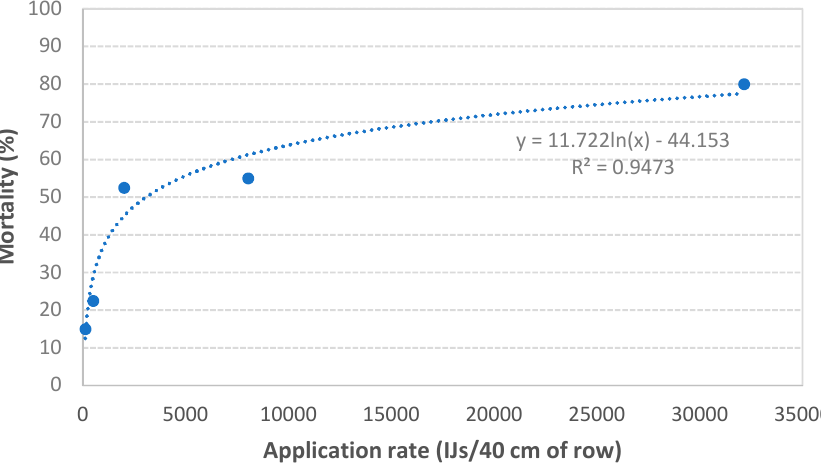
Figure 6. Mortality of Galleria mellonella larvae within the cane rhizome, by Steinernema rarum (Pam 25) at rates of 125, 502, 2009, 8038 and 32,153 IJs/40 cm of row, two weeks after the application.